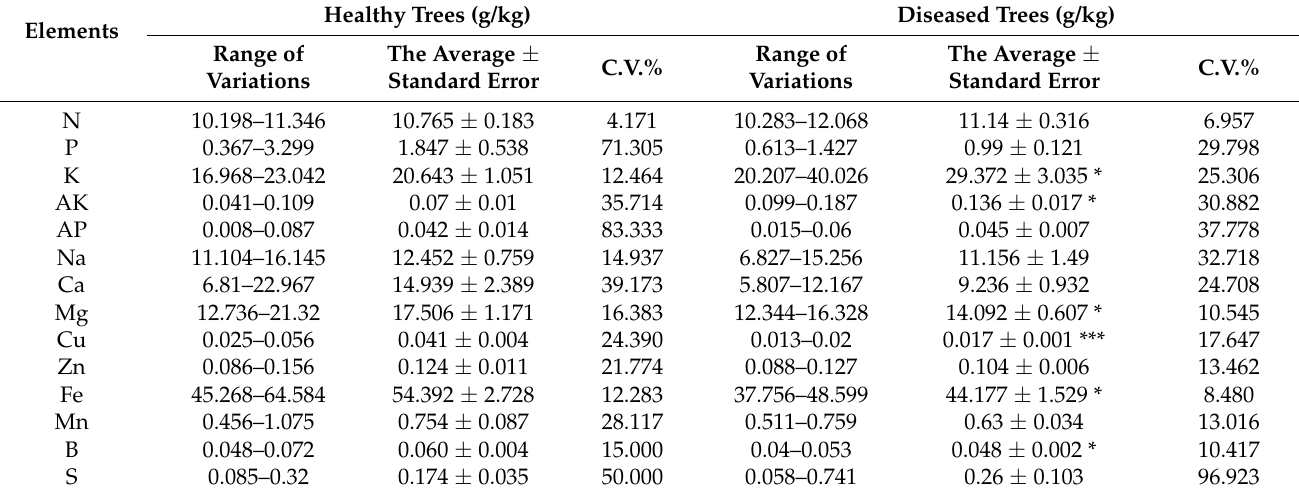
Table 3. Soil nutrient elements in healthy and diseased chestnut